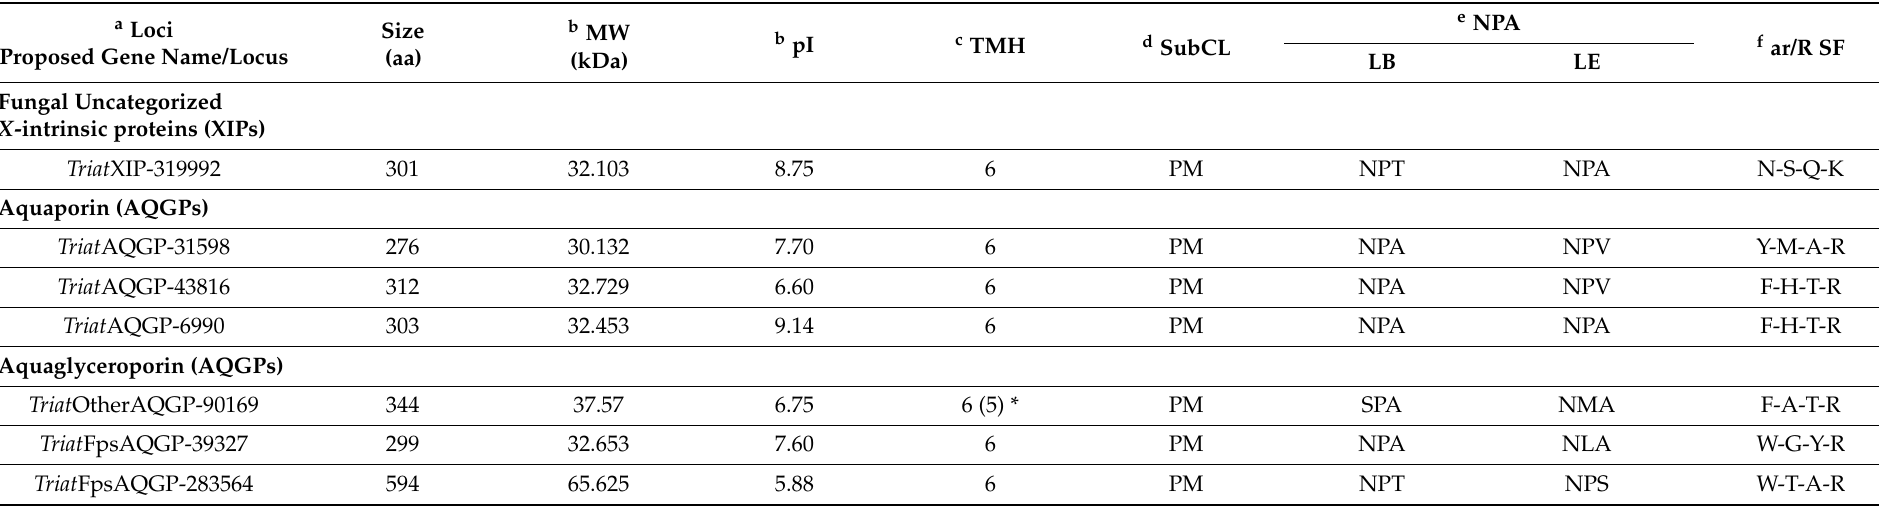
Table 1. Nomenclature and protein properties of Triat MIPs from Trichoderma atroviride